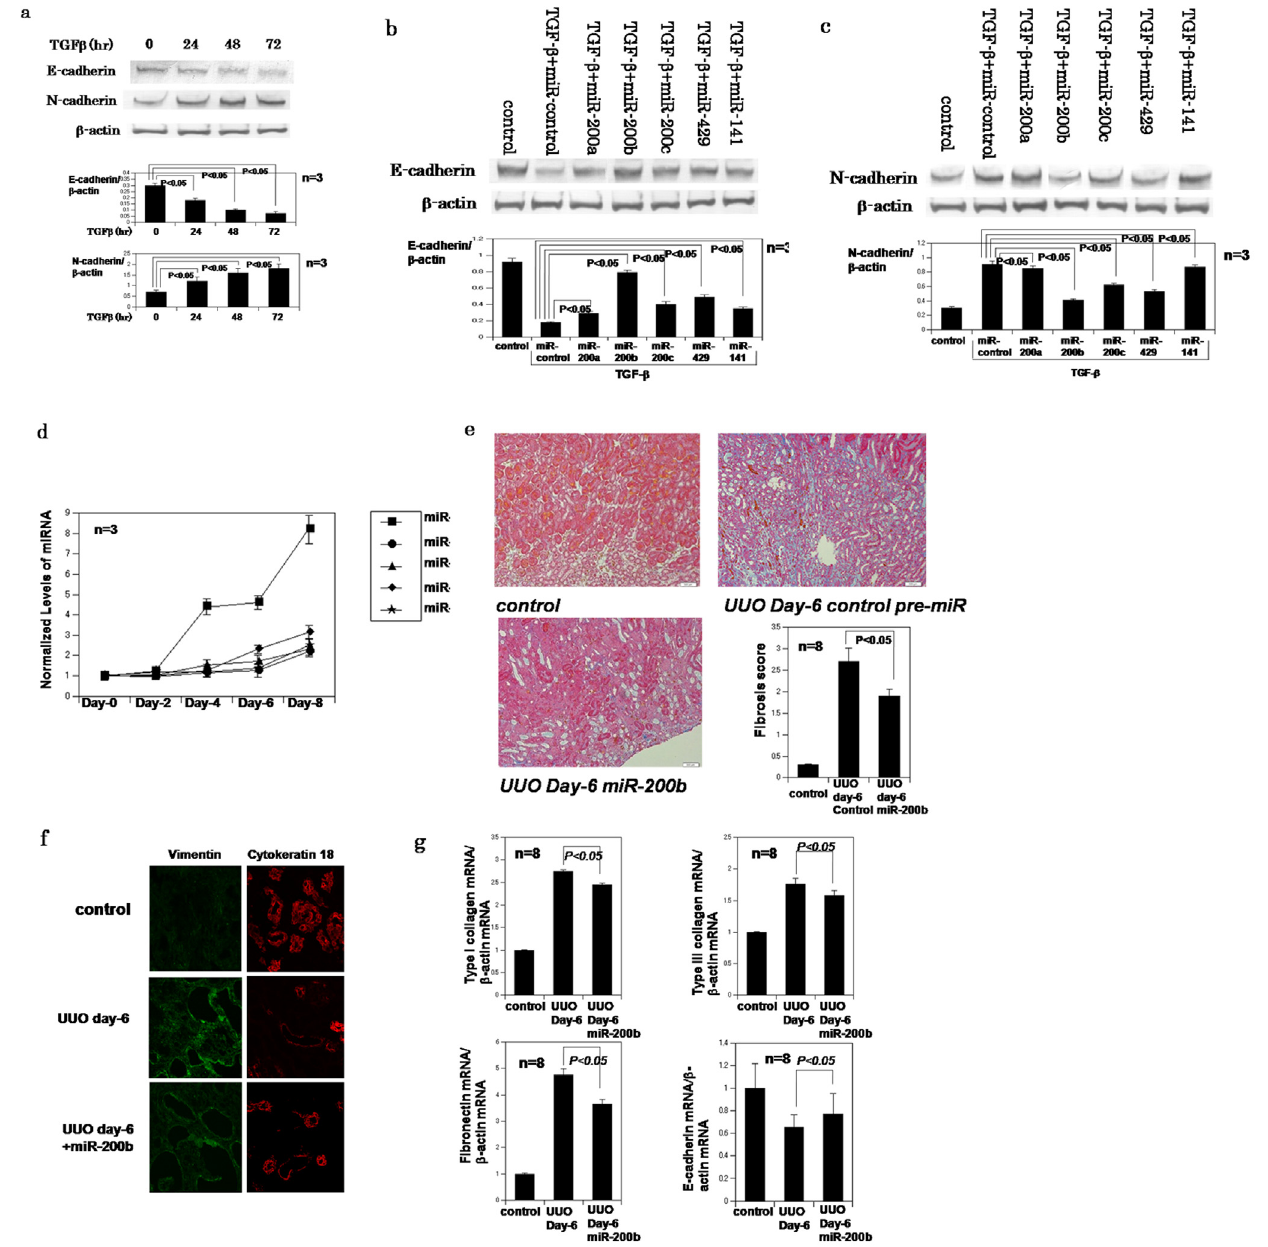
Figure 1. miR-200 family members can ameliorate EMT and tubulointerstitial fibrosis in UUO model mouse kidneys. a , Western blotting analysis confirms down-regulation of E-cadherin and up-regulation of N-cadherin during EMT. b , c , Western blotting of E-cadherin and N- cadherin in HK-2 cells treated with TGF-beta and transfected with control miR or miR-200 members precursors individually. In western blotting, each band has been quantitated and subjected to densitometry to determine if statistically significant difference exists between groups d , Changes in miR-200 family levels in UUO model mice kidneys, as measured by TaqMan qRT-PCR and normalized to U6 expression. The data are means from a representative time course experiment measured in triplicate and are presented as mean 6 S.E. e , Azan staining of intact Balbc mouse kidney, UUO day-6 kidneys after transfection of negative control pre-miR or miR-200b precursor. Fibrosis score; The tubulointerstitial fibrosis score in kidneys of miR-200b precursor injected group was significantly lower than of control group: P , 0.05, The data are means from experiment measured in triplicate and are presented as mean 6 S.E (n=8) f , Immunofluorescence studies of vimentin and cytokeratin 18 in the kidneys of UUO day6 mice and UUO day6 mice injected by miR-200b precursor. miR-200b ameliorates up-regulation of vimentin and down-regulation of cytokeratin 18. g , real-time PCR confirms that miR-200b precursor reverses up-regulation of type I,III collagen and fibronectin of UUO day-6 kidneys. The data are normalized to beta- actin mRNA and shown as mean 6 S.E.(n=8). doi:10.1371/journal.pone.0013614.g001 vein prior to occlusion of the left ureter. A single injection of observation confirmed by real time PCR analysis of type I 0.5 nM miR-200b precursor was sufficient to ameliorate tubulo- collagen, type III collagen and fibronectin and Azan staining interstitial fibrosis in the kidney 6 days after UUO (Fig. 1e), an (Fig. 1e). To demonstrate that reduction of ZEB1 and ZEB2 levels